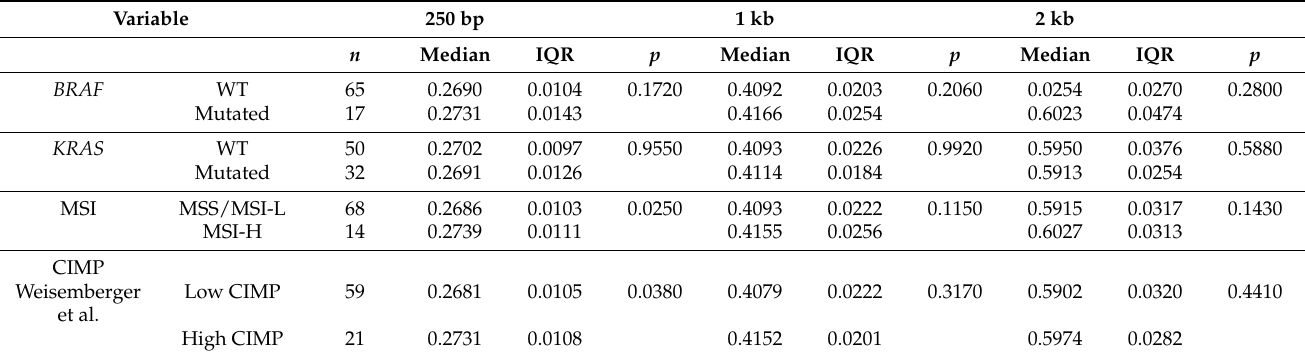
Table 4. Associations of global methylation scores and molecular features of the colorectal carcinomas of the study patients. Variable 250 bp 1 kb 2